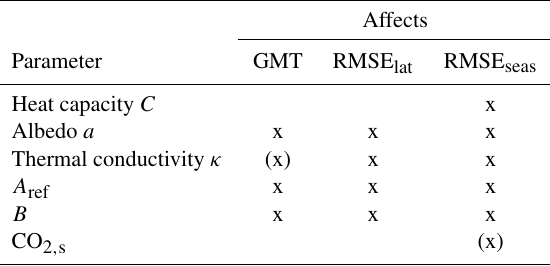
Table 5. List of the parameter groups and which of the tuning met- rics (GMT, RMSE lat , and RMSE seas ) they affect based on the re- sults shown in Fig. 8 and 9. Bracketed markers (x) represent a no- tably smaller but not negligible influence by that parameter on the tuning metric in comparison to the other